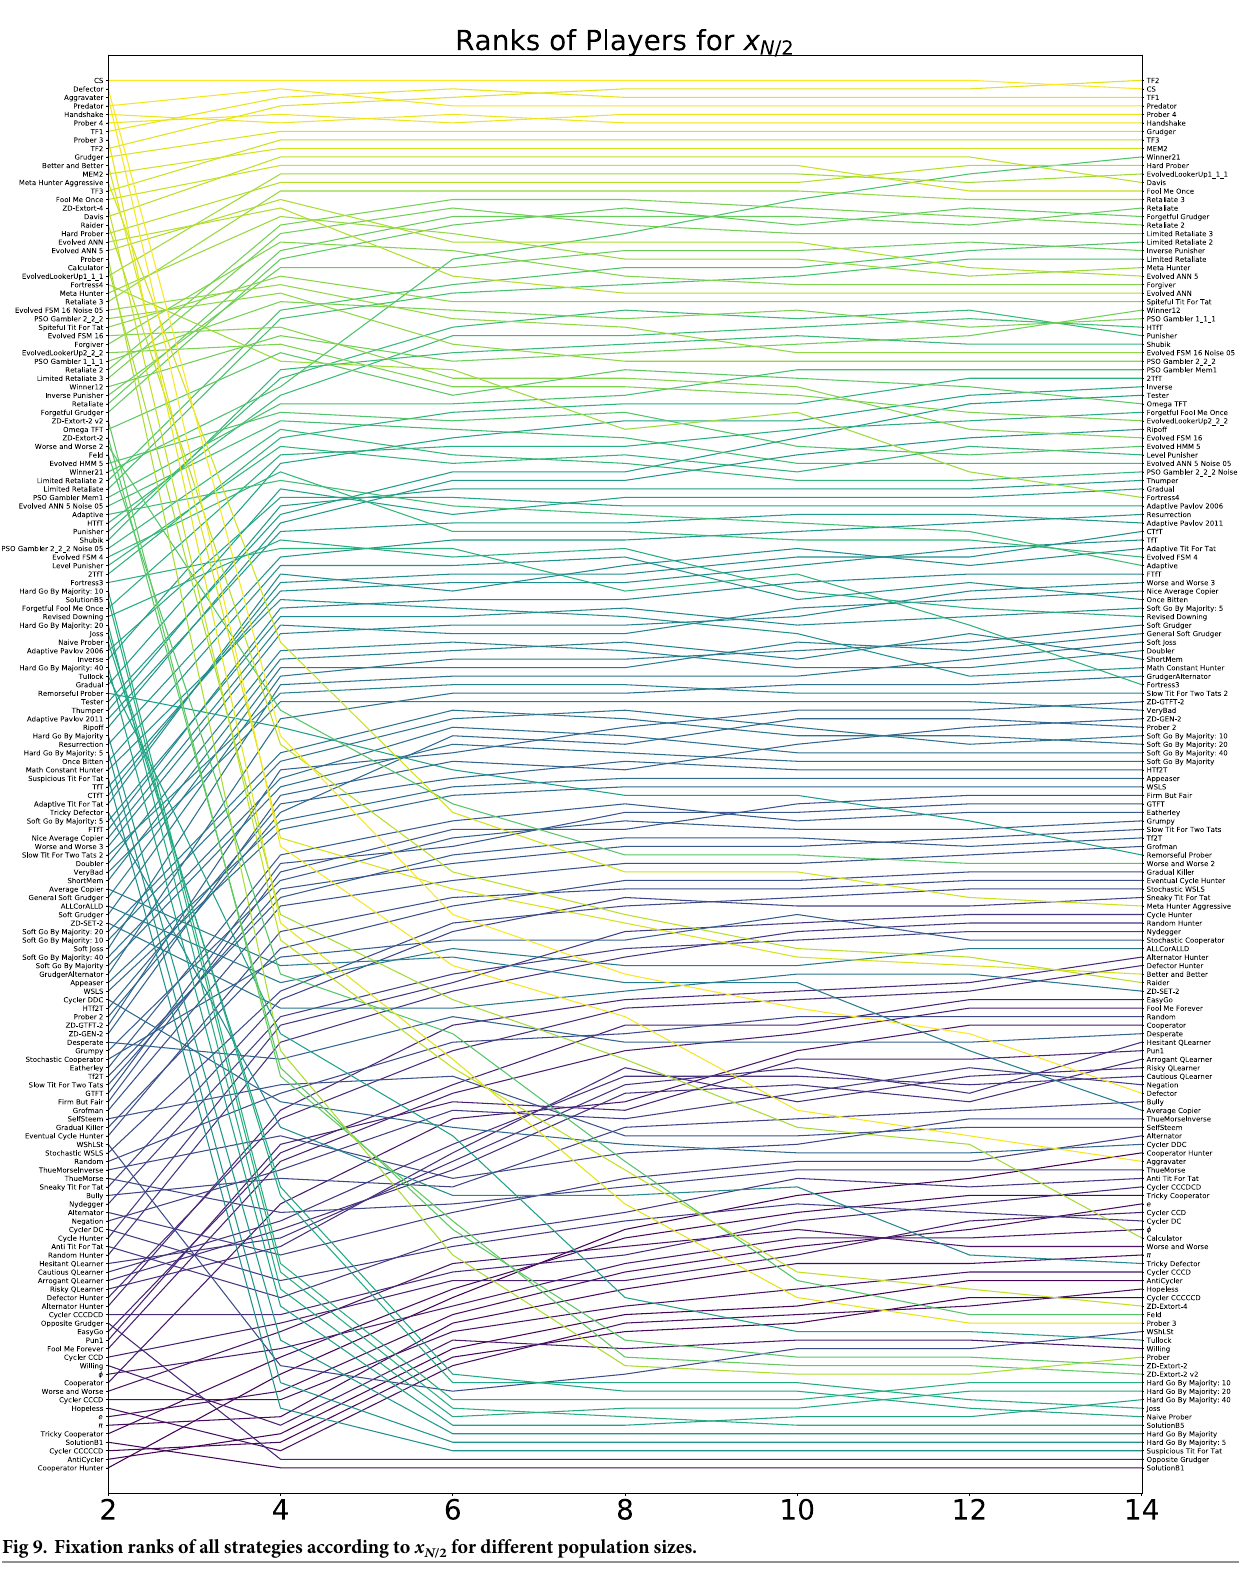
Fig 9. Fixation ranks of all strategies according to x N /2 for different population sizes.